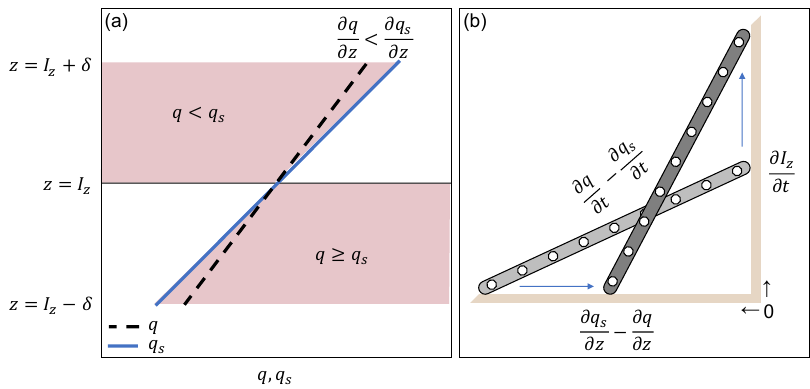
Figure 1. ( a ) Sketch of the conditions in which fog exists, following Equation (4). Given the hypothetical profile of q s near the interface, the profile of q must exist within the shaded regions, represented by the dashed line. ( b ) Equation (7) illustrated as a ladder against a wall. The shallower (steeper) the ladder, the lesser (greater) the distance that can be travelled